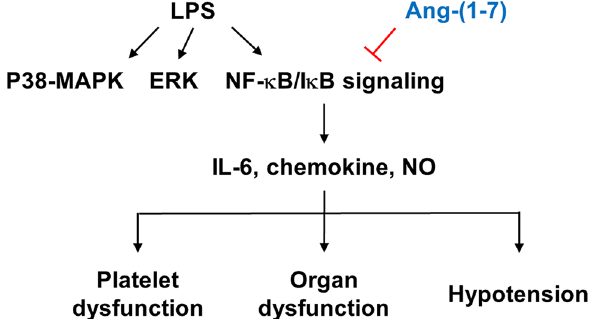
Figure 10. Schematic diagram of the effects of angiotensin-(1–7) in rats with endotoxaemia. ERK: extracellular signal-regulated kinase; IL: interleukin; NF-κB; nuclear factor kappa B; NO: nitric oxide; p38 MAPK: p38 mitogen-activated protein